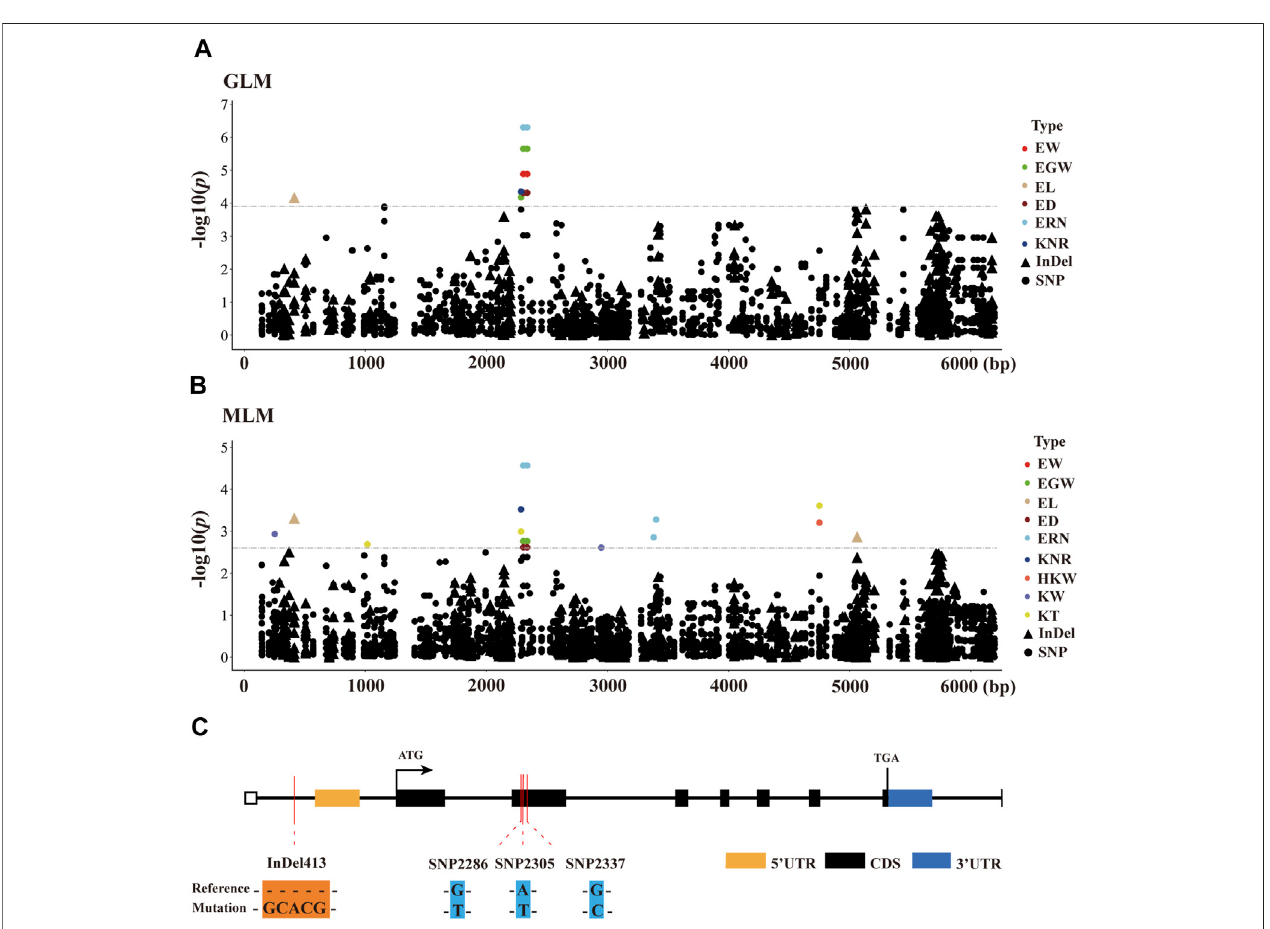
FIGURE4| Candidate-genebasedassociationof ZmCNR13 geneininbredlines. (A,B) ManhattanplotusingtheMLMandGLMmodel.The p -valuethresholdwas setat1/398(MLM)and0.05/398(GLM).TrianglesanddotsrepresentInDelsandSNPs,respectively. (C) Schematicofthe ZmCNR13 genestructureandallelicvariation.